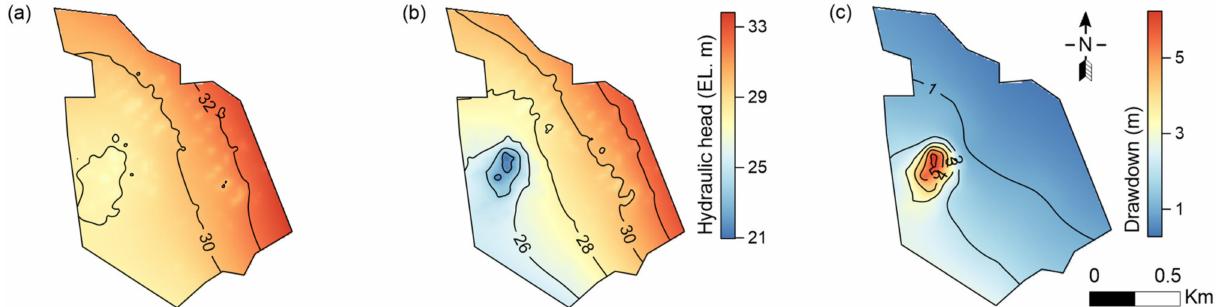
Figure 6. Changes in calculated groundwater levels due to opening of the weir during the seasonal pumping period, when the river level is ( a ) at the Ipo Weir management level (28 m), ( b ) at the minimum weir level (25.3 m), and ( c ) groundwater